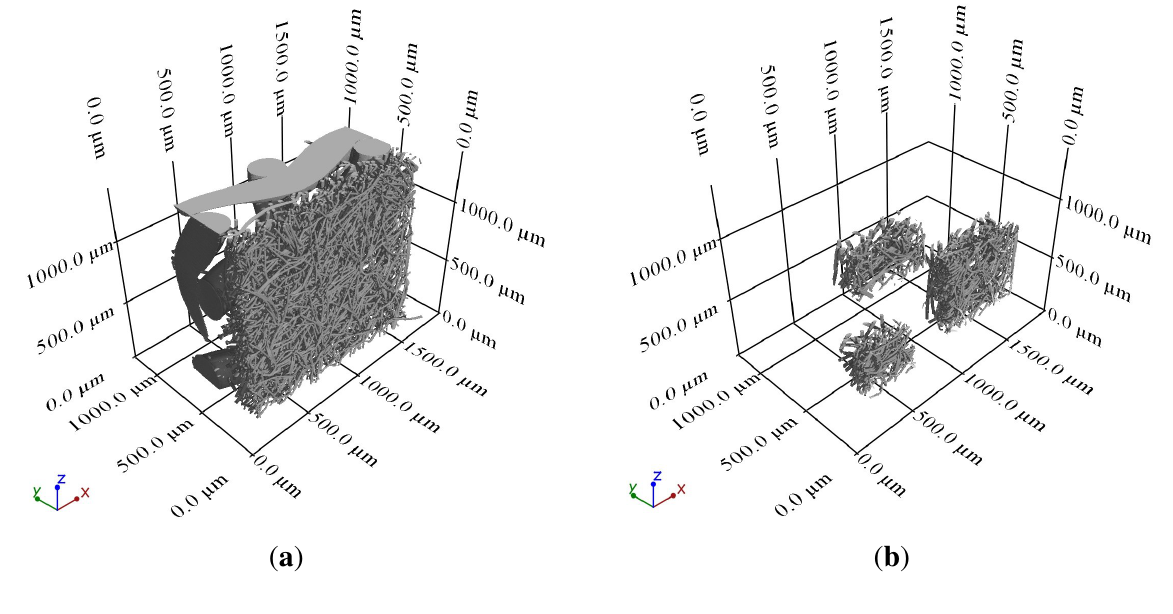
Table 1. Material properties of sintered fibre felts (SFF), porosity ( σ ), thickness of functional layer ( t ), fibre diameter of layers 1 and 2 ( d Physikalisch-Technische Bundesanstalt in Braunschweig according to DIN EN 29053 ( Ξ calculated flow resistivity ( Ξ